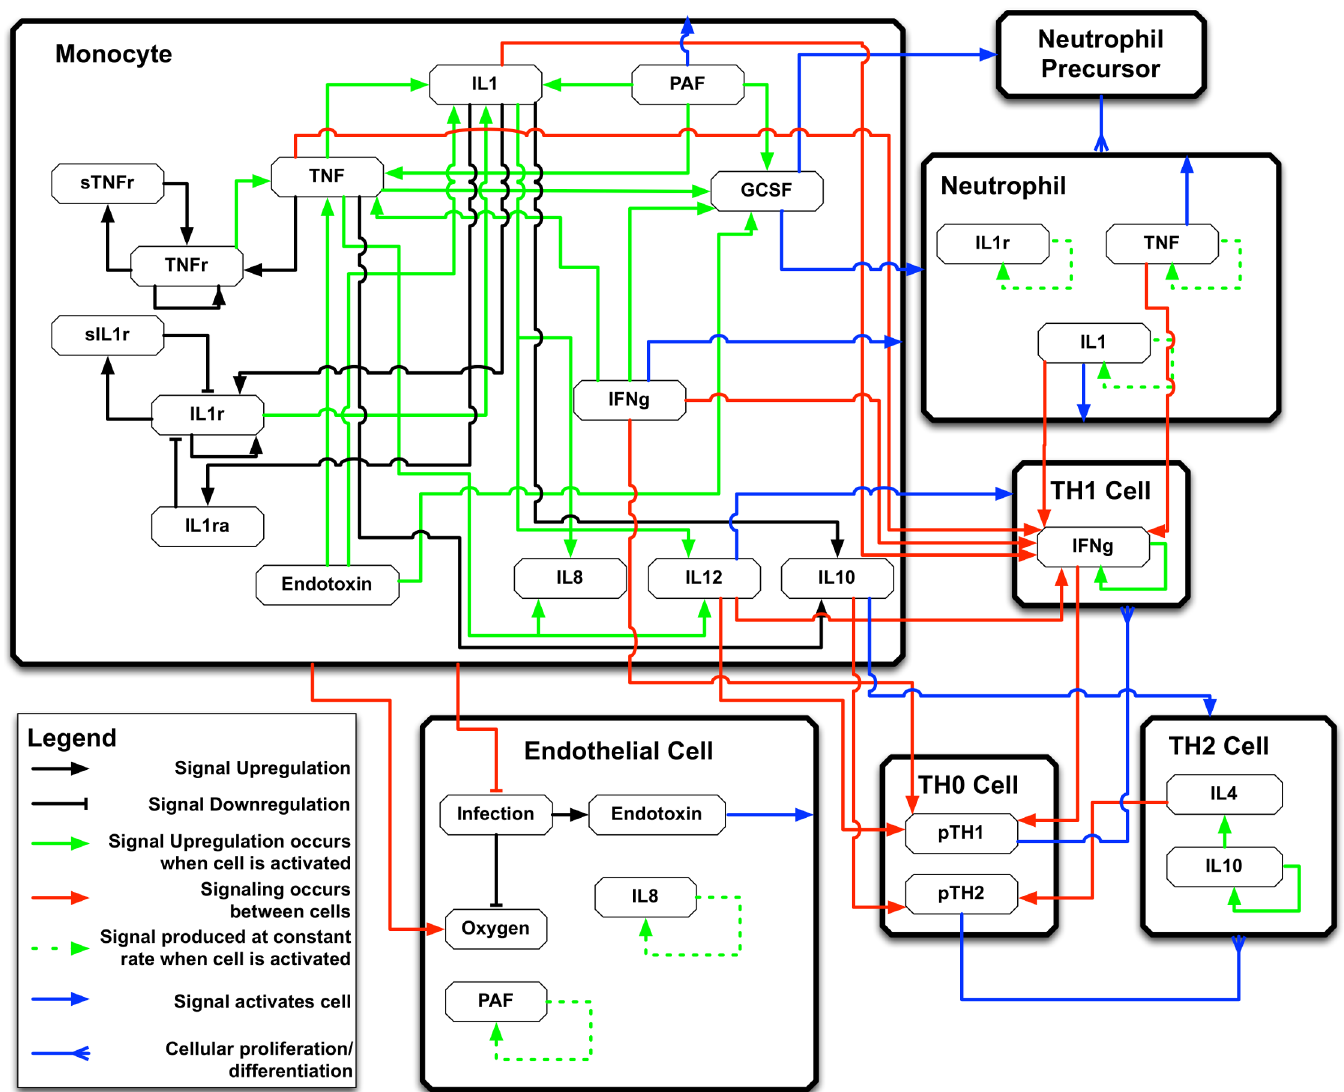
Fig 1. IIRABM schematic diagram. This is a high-level overview of the signaling rules incorporated into the IIRABM. Rules represented include cytokine up-regulation/ down-regulation, cell activation, and cellular